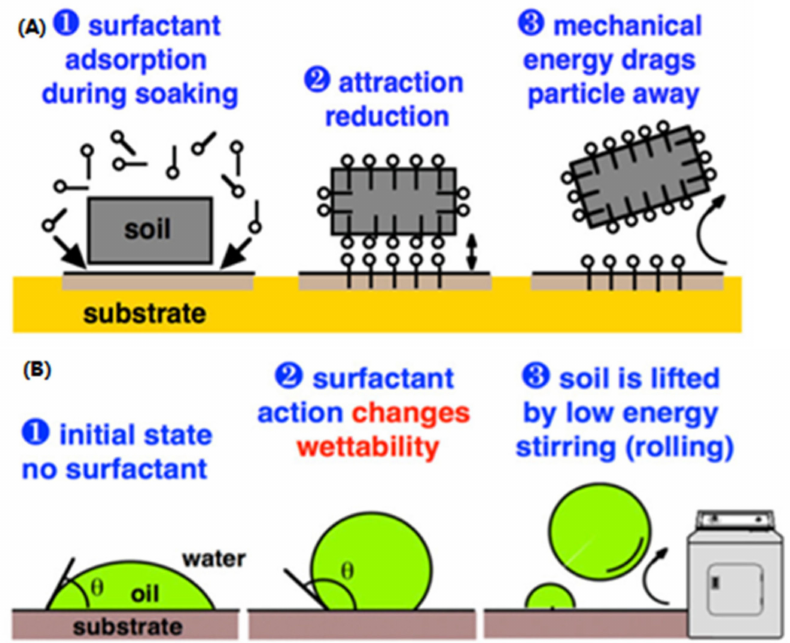
Figure 18. Mechanisms of takeoff of dirt of a solid substrate. ( A ) Dirty solid on a solid. ( B ) Dirty liquid on a solid.